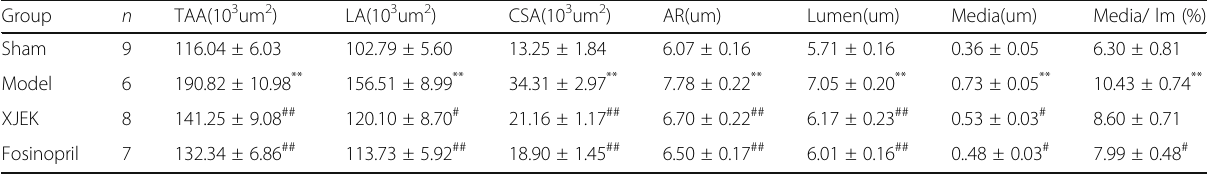
Table 4 Effects of XJEK on thoracic aorta remodeling of MI mice (mean ± SEM) Group